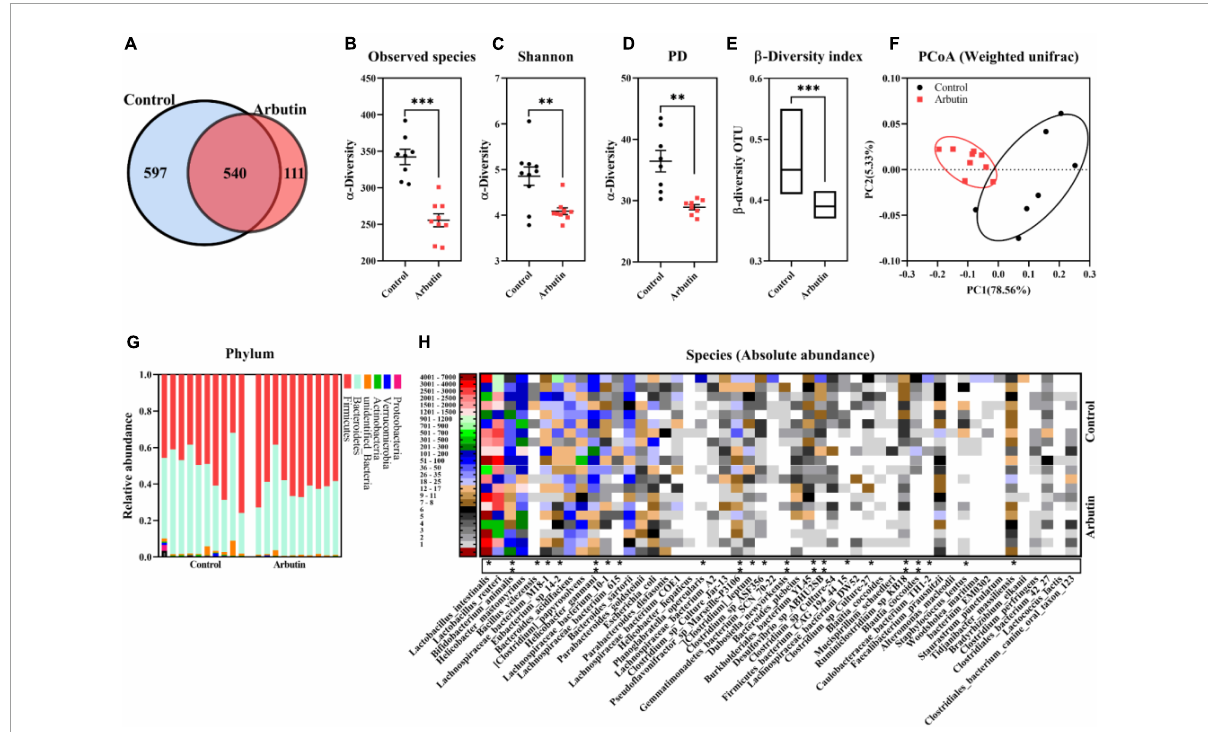
FIGURE3 Arbutin alters the gut microbiota. Venn diagram (A) , observed species (B) , Shannon index (C) , PD_whole_tree (D) , β -diversity index (E) , principal component analysis (F) , phylum (G) , and species (H) were analyzed at 0.4 mg/ml. Differences were assessed by t -test and denoted as follows: